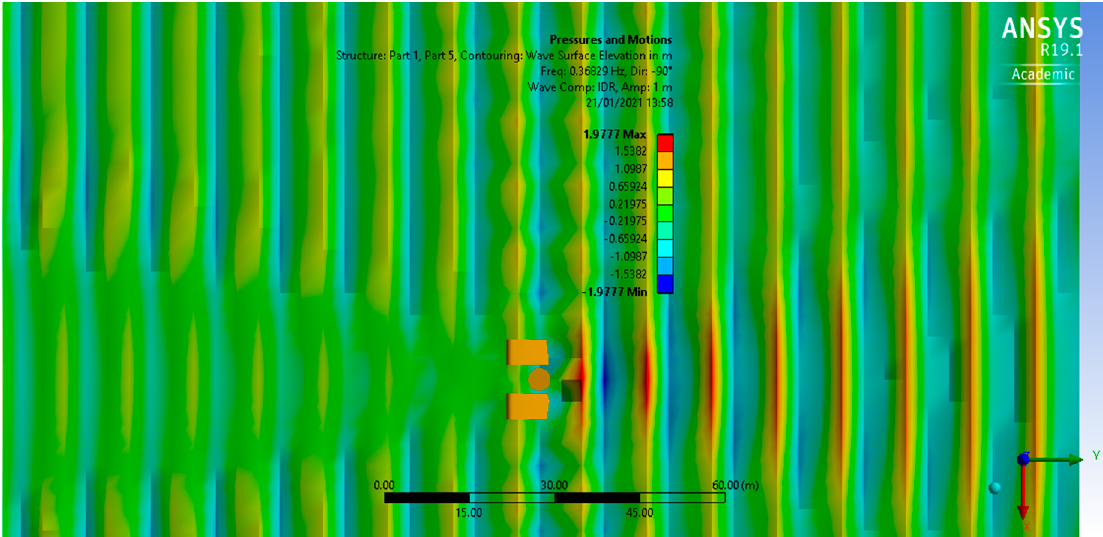
Figure 6. Example of CECO’s disturbance of the lee-wake flow, with the incident wave height being reduced, due to wave absorption by the power take-off system (PTO) (waves from right to left).